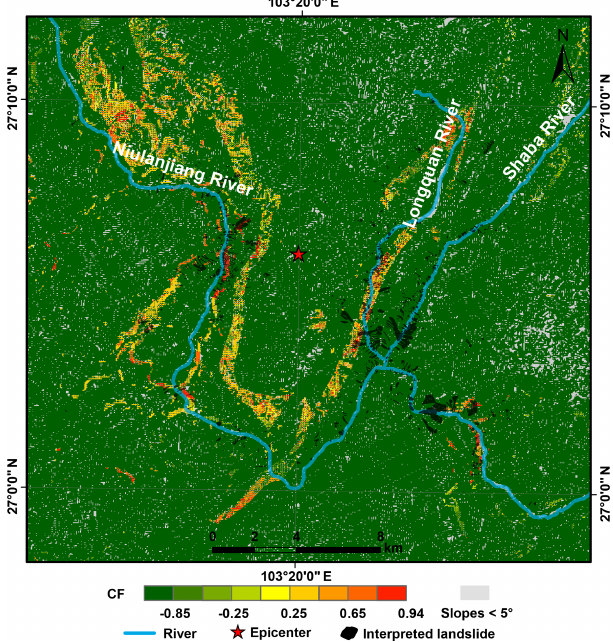
Figure 19. Map showing confidence levels of coseismic landslides during the Ludian earthquake using a conventional Newmark anal- ysis. Confidence levels are portrayed in terms of values of CF.